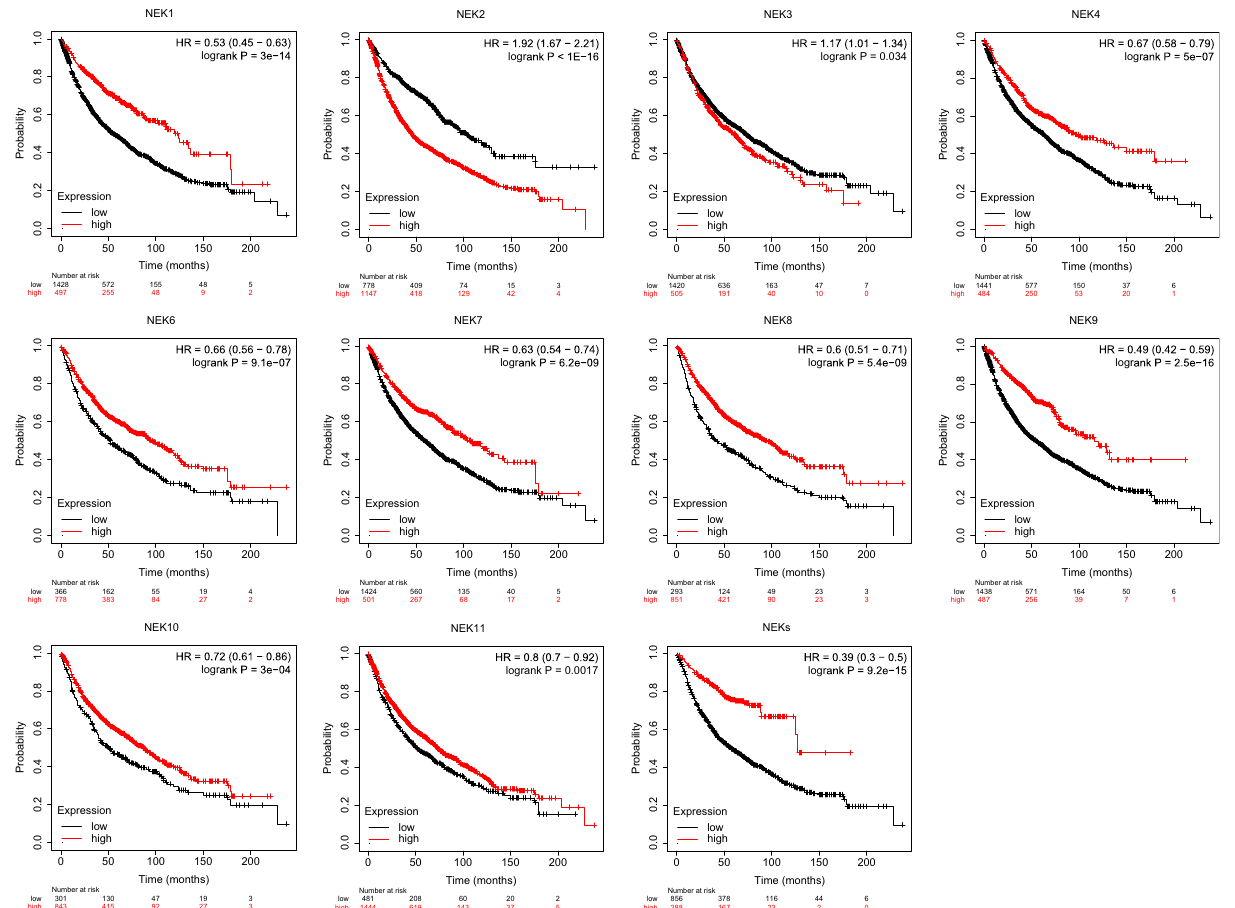
Figure 6. Prognostic value of mRNA expression of distinct NEKs family members in NSCLC